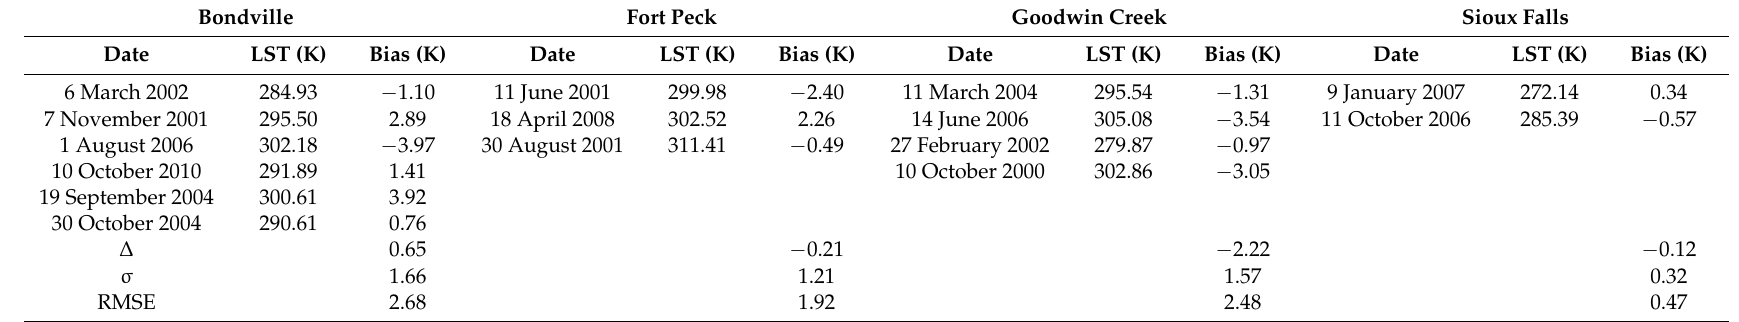
Table 9. Comparison of LST values derived from the SURFRAD stations and the LST inverted by the Planck function using band 13 of the ASTER instrument. Bondville Fort Peck Goodwin Creek Sioux Falls